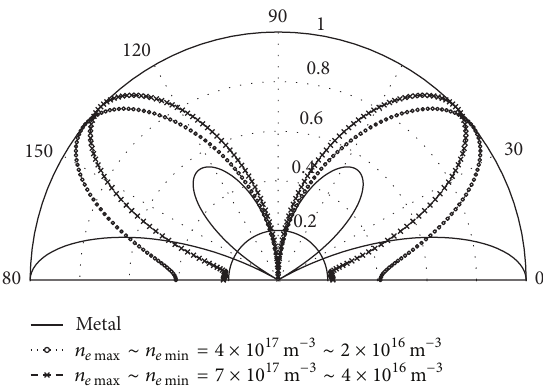
Figure 1: Normalized radiation pattern of the plasma